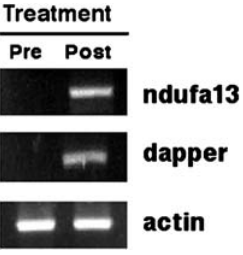
Figure 6. Gene expression by RT-PCR. RT-PCR of NDUFA13 and DAPPER genes in biopsies from the primary tumor showing that these